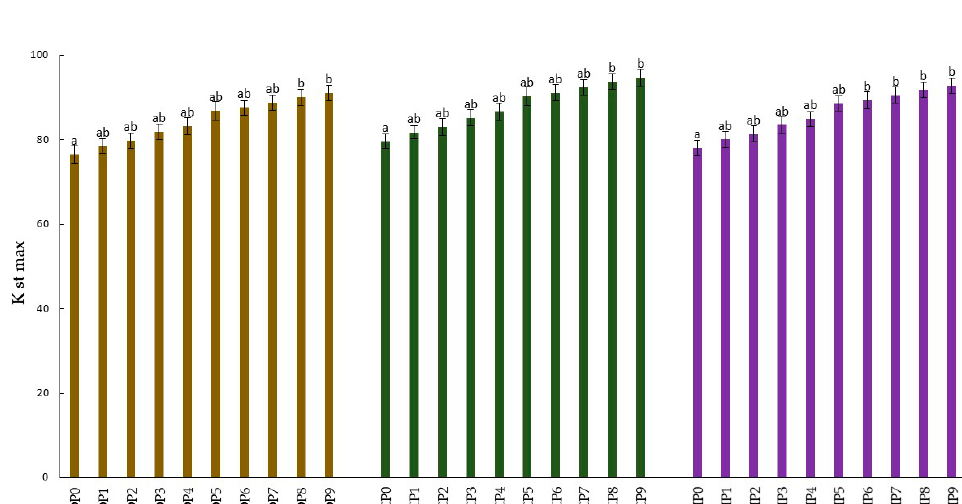
Figure 4. Dust explosivity index of oak, coniferous, mixed pellets and produced biocarbons. Statisti- cally significant differences between values are marked by different letters ( p ≤ 0.05).